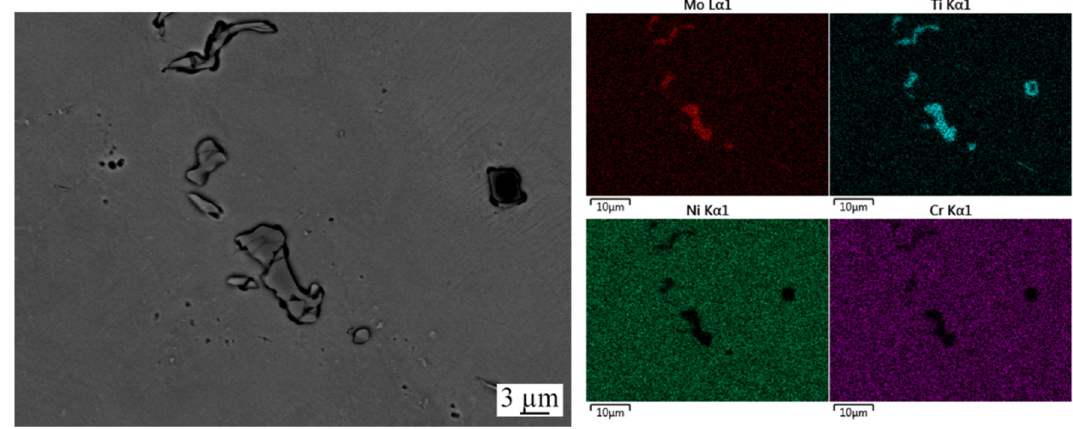
Figure 6. SEM-EDS maps showing segregation of Ti–Mo-rich carbides after heat treatment at 1190 °C/4 h.